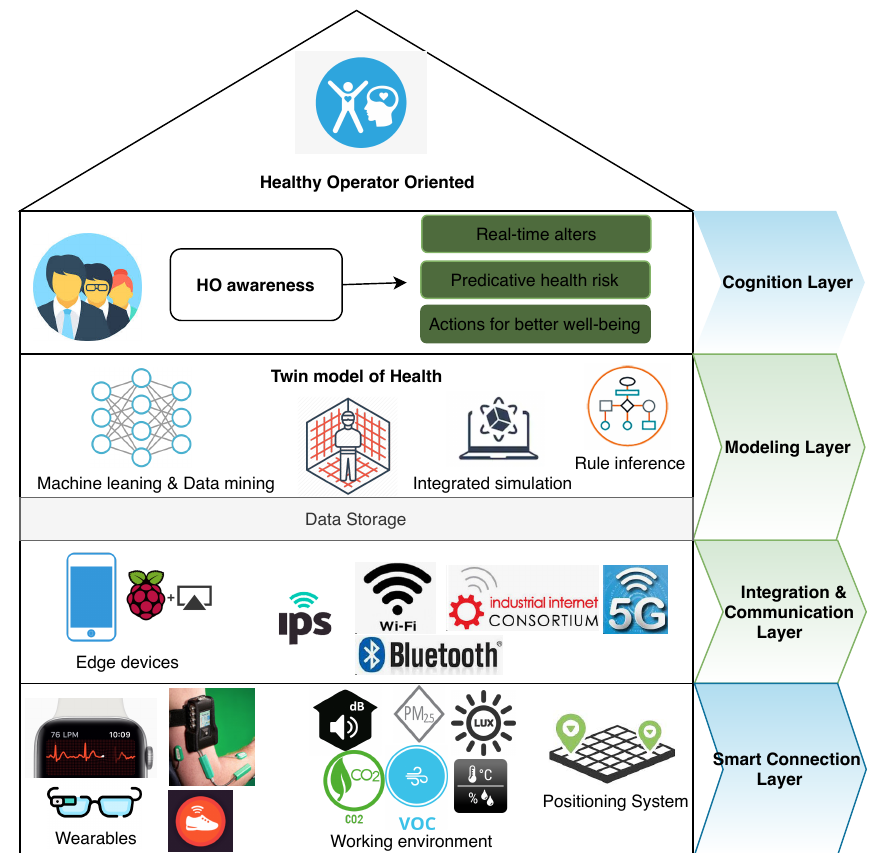
Figure 1. Healthy Operator 4.0 (HO4.0)